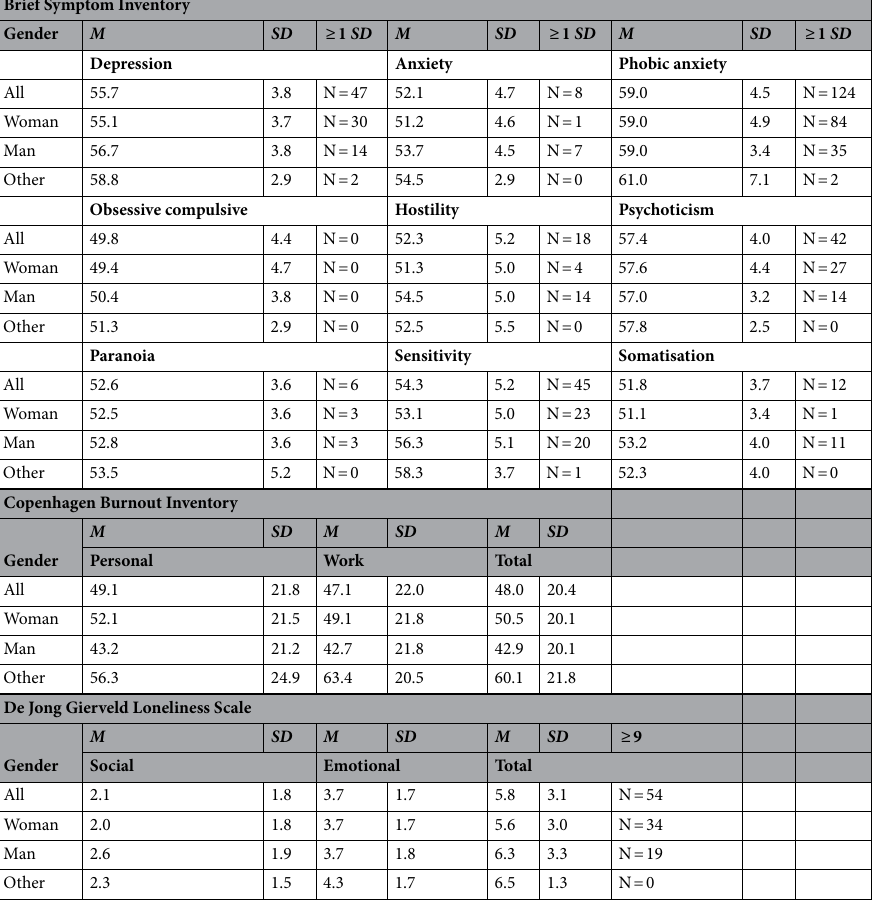
Table 1. Means (M) and standard deviations (SD) for the standardized mental health measures divided by gender. Note: Participants who indicated “prefer not to answer” (N = 5) were not included in the table.